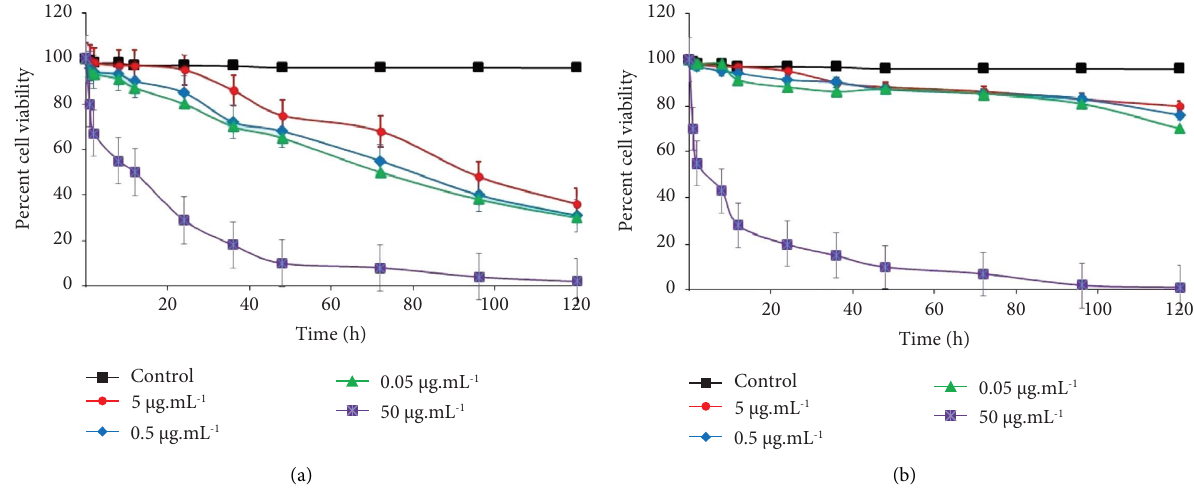
Figure 5: Demonstrates the survival of NCI-H69 cells following treatment by (a) Fluracil ® or (b) the vehicle Cre-EL. Cells were plated into 96-well culture plates and exposed to varying dosages of both formulations for 24, 72, 96, and 120hours at 37 ° C, as mentioned in the experimental section.